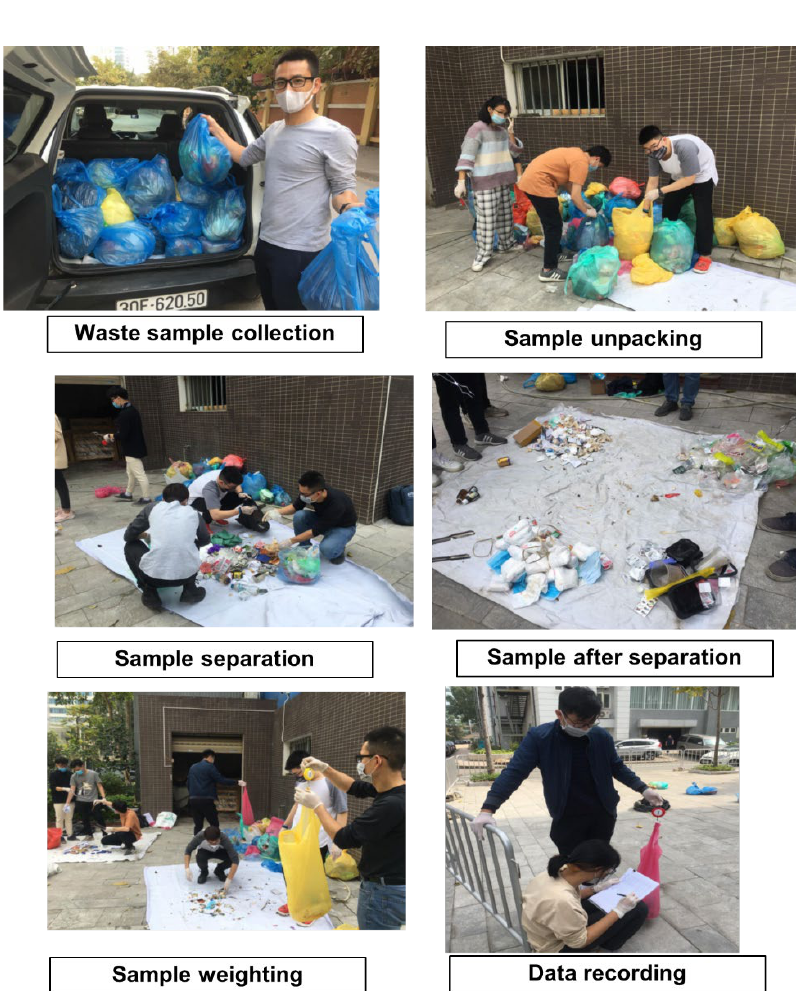
Figure A1. Waste sampling and analysis images.